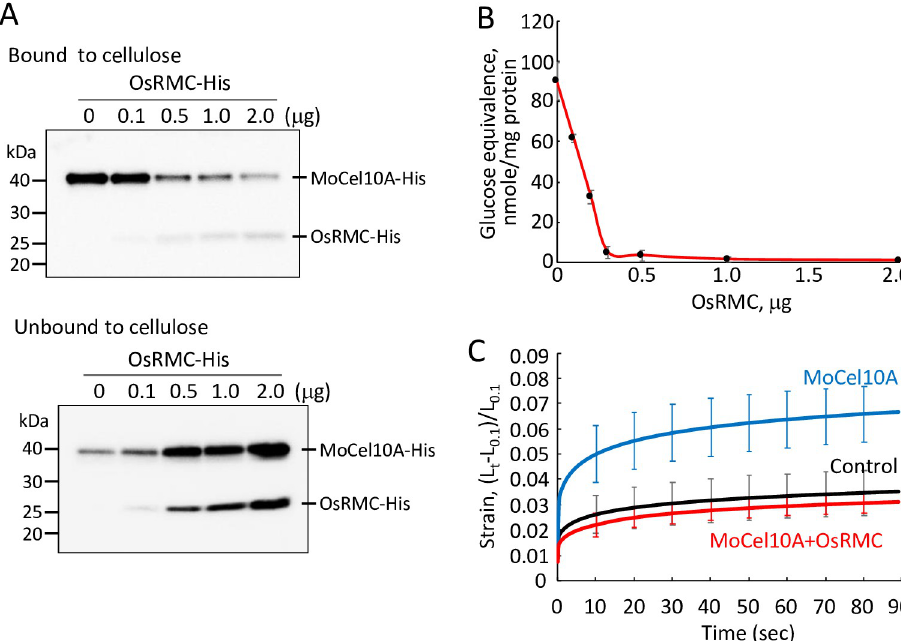
Fig 2. Binding of OsRMC to CBM1 causes to inhibit catalytic activity. (A) MoCel10A-His was incubated with cellulose in the presence of a protein mixture (total 2.0 μ g) of OsRMC-His (0–2.0 μ g) and BSA (2.0–0 μ g) for 1 h at 4˚C, and proteins bound and unbound to cellulose were detected by immunoblot analysis using anti-His antibody. (B) MoCel10A-His (2.0 μ g) was preincubated with a protein mixture (total 2.0 μ g) of OsRMC-His (0–2.0 μ g) and BSA (2.0–0 μ g) for 30 min 4˚C, and the hydrolytic activity towards a wheat cell wall preparation was determined. Data are means ± SD of three independent determinations. (C) Heat-inactivated wheat coleoptile segments were treated with sodium phosphate buffer (100 mM, pH 6.0) containing MoCel10A-His (2.0 μ g) with BSA (2.0 μ g) or a mixture of MoCel10A-His and OsRMC-His (2.0 μ g each). Samples treated with buffer were used as a control. Extension measurement was performed by loading a constant 200 mN to approximately 5-mm segments for 3 min in an extensometer. Strain was calculated as ( L t −L 0.1 )/ L 0.1 ( L t , length of coleoptiles at each time point; L 0.1 , length of segments at time 0.1). Data are means ± SD of five independent